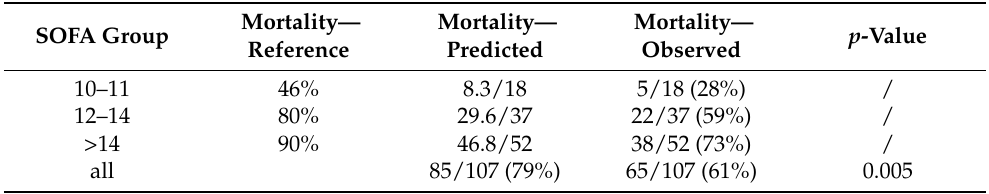
Table 5. Highest SOFA score and observed vs. predicted ICU mortality rate. Comparison for grouped ICU mortality by Chi-squared test.